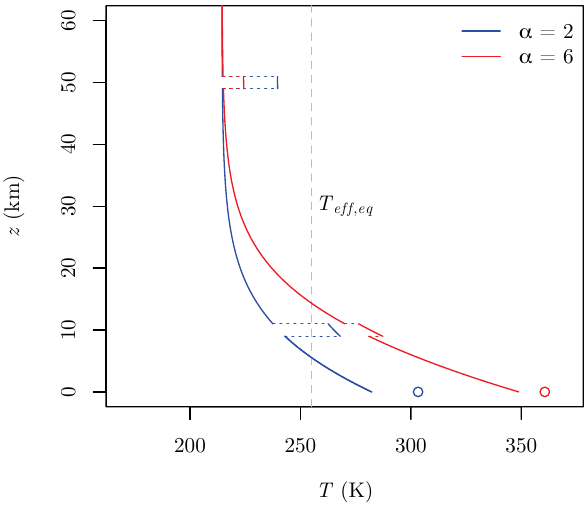
Figure 8. Vertical temperature profiles of a grey atmosphere that is additionally locally heated (e.g., by absorption of solar radiation) at two heights within the atmosphere. Apart from the heights at which the profiles are locally deflected due to additional heating, the blue and red curves show the same grey equilibria as the corresponding curves in Fig. 2. Again α corresponds to α o in the window-grey model with β w = 0. The heights at which additional heating occurs ( z 1 ≈ 10km, z 2 ≈ 50km) and the magnitude of the additional heat- ing terms (specified such that the temperature rise is 25K for α = 2 at both heights) are more or less arbitrarily chosen to demonstrate the effect. T eff,eq = 255K. The circles at z = 0 denote the corre- sponding surface temperatures. Note that the vertical coordinate z is only approximate height, calculated from h with a constant scale height H = 8km such that h = 1 − e − z/H